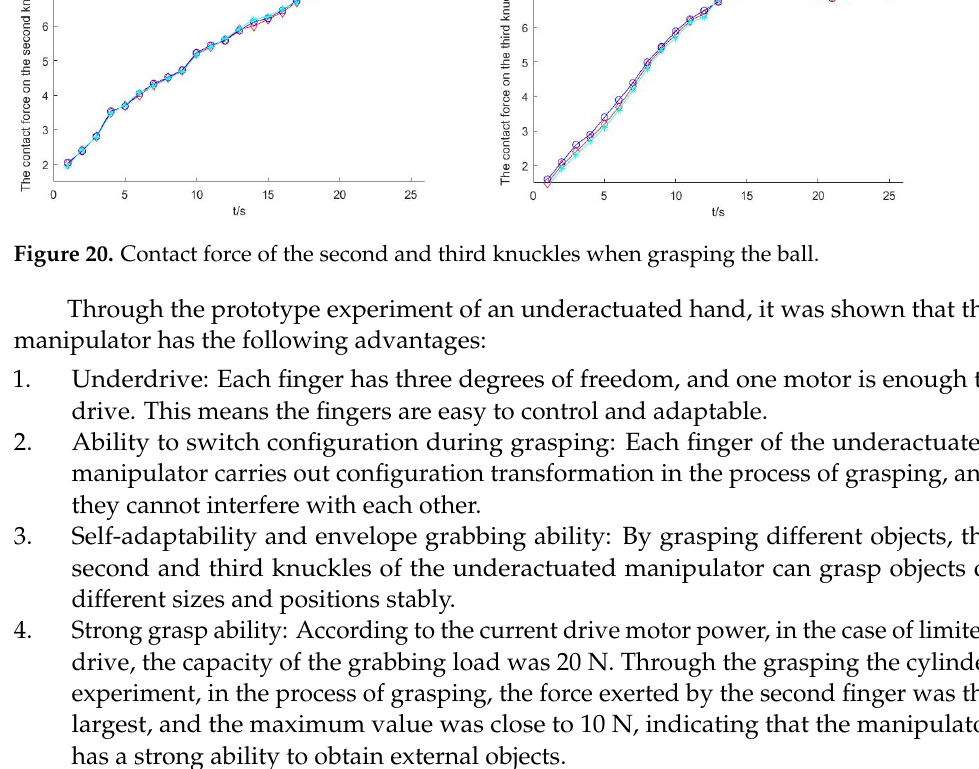
Figure 19. Grabbing an apple experiment.